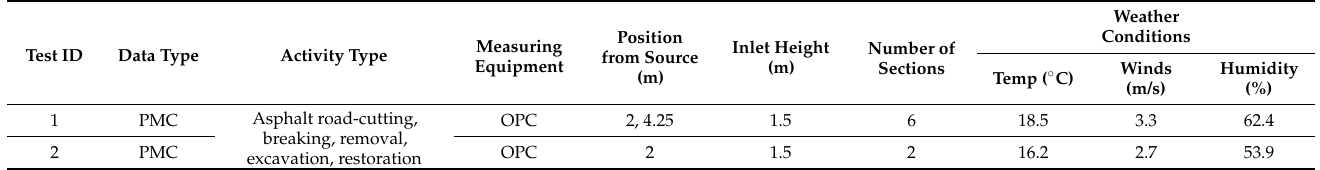
Figure 2. ( a ) Equipment for collecting background data, ( b ) first field testbed (sections 1–6), and ( c ) second field testbed (sections 1, 2). Table 3. Measurement conditions for excavation and restoration work .